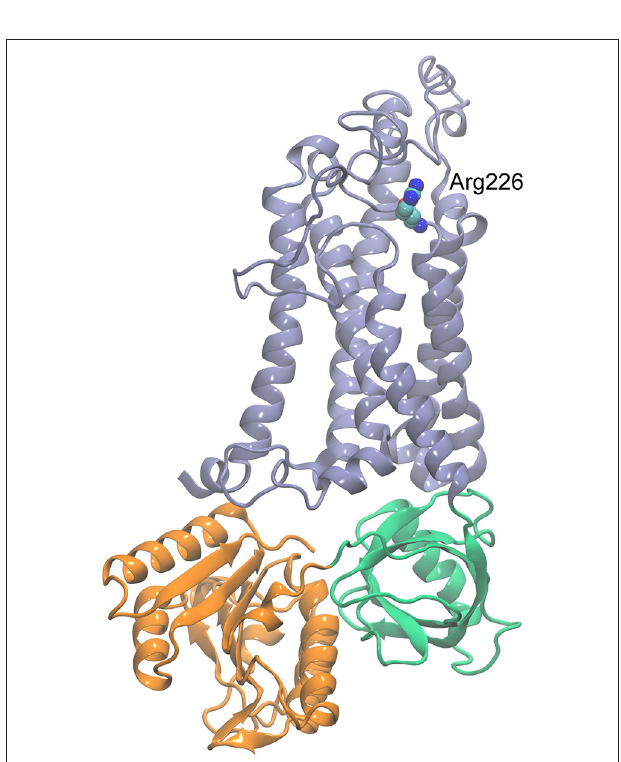
FIGURE 4 | Homology model of CYBB generated with SWISS-MODEL (https://swissmodel.expasy.org/) using the dual oxidase 1 (DUOX1; Protein Data Bank ID: 7D3E) structure as the template. The transmembrane region is shown in blue, FAD-binding domain in green, and NADPH-binding domain in orange. Arg226 is shown in space-filling